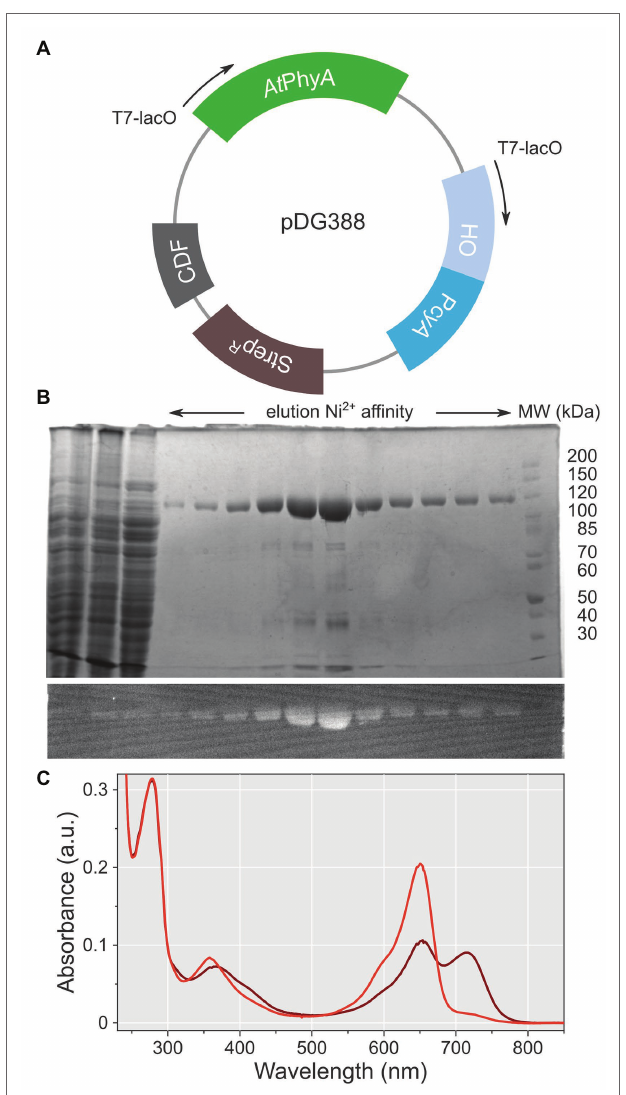
FIGURE 2 | Expression, purification, and spectroscopic characterization of full-length At phyA. (A) The plasmid pDG388 harbors expression cassettes for At phyA and for heme oxygenase (HO)/PcyA, respectively. Both cassettes are expressed from T7 promoters under the control of lacO . The vector carries a CDF origin of replication and a streptomycin resistance marker (StrepR). (B) Purification of At phyA by Ni 2+ immobilized metal ion affinity chromatography. The upper panel shows a Coomassie-stained denaturing polyacrylamide gel, and the lower panel the corresponding zinc-induced bilin fluorescence. (C) UV/vis absorbance spectra of At phyA after illumination with 650 nm (brown) and 720 nm (red),